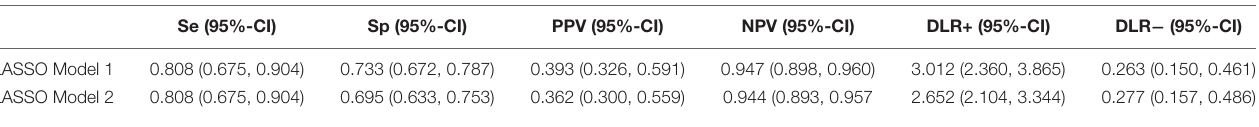
TABLE 4 | Diagnostic accuracy